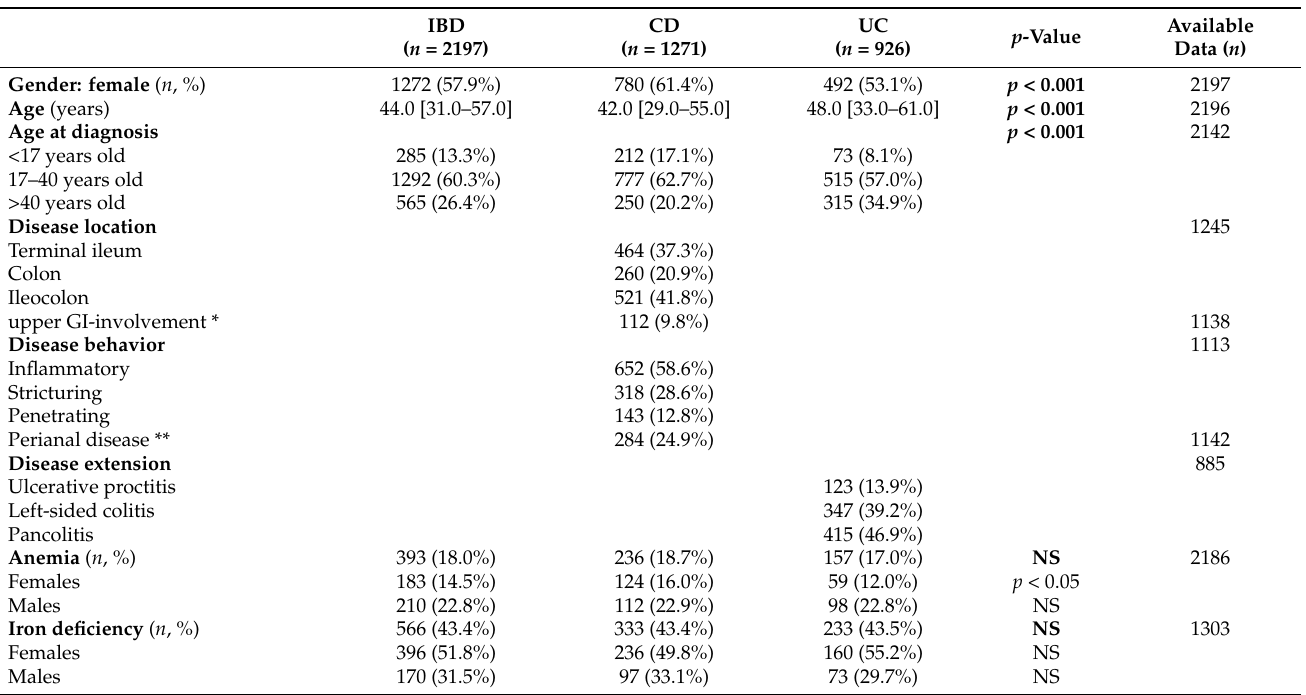
Table 1. Study population